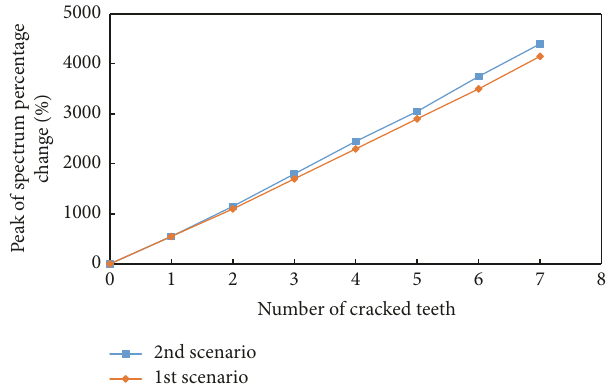
Figure 45: Spectrum of the residual signal obtained for the third scenario (Case (7) with nonconsecutive cracked teeth).